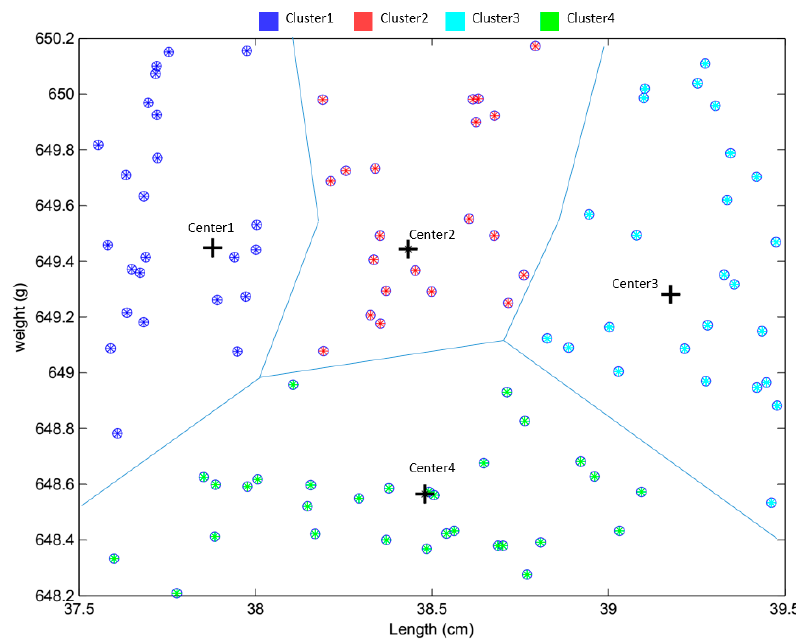
Figure 2. The feature fuzzy clustering of flatfish by its size (weight and length).